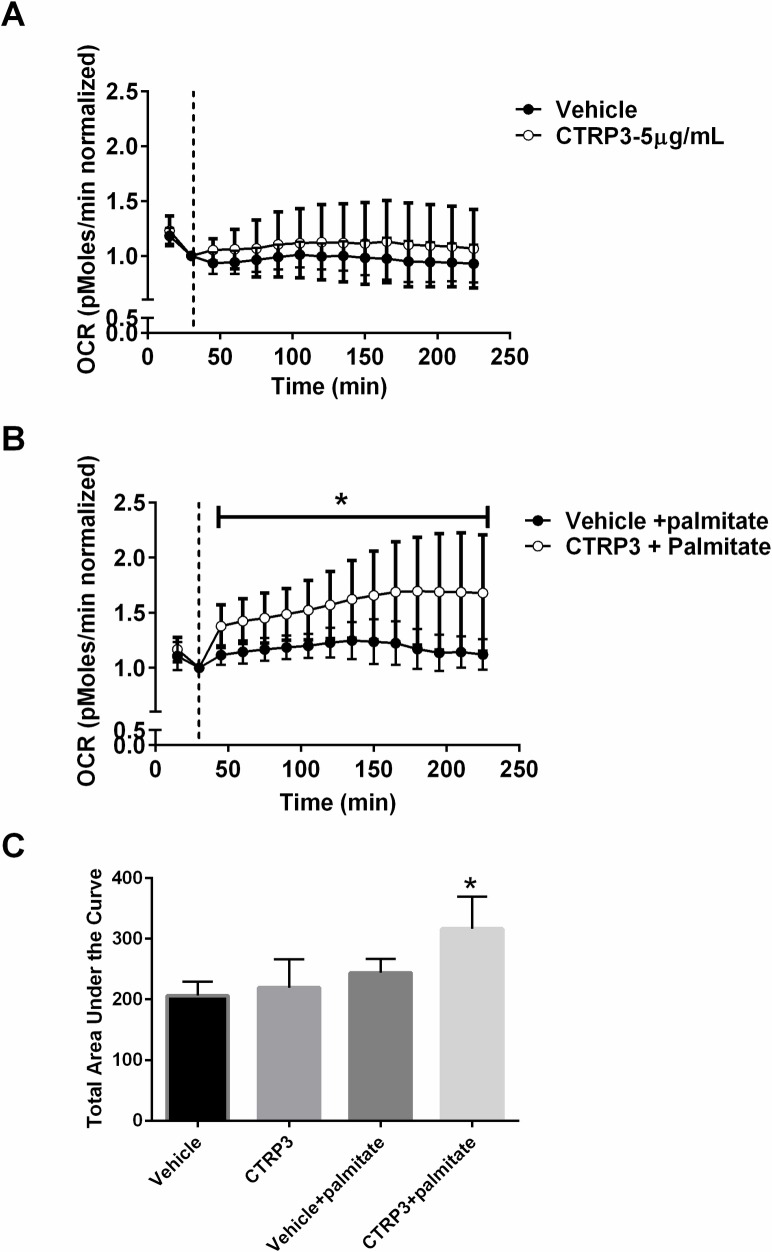
CTRP3 increases oxygen consumption.Cells were pre-incubated with 5 μg/ml recombinant CTRP3 or vehicle for 1 H before being placed into the XFe24 Extracellular Flux Analyzer (Seahorse Bioscience) and oxygen consumption rate (OCR) was determined. OCR was measured in the absence (A) or after the addition of 200 μM palmitate (B) added at 15 minutes (vertical line). C, Area under the curve was calculated (mean OCR value at each interval*time) for each treatment. Data represents the mean ± SD. Data represents pooled data from 3 independent experiments each performed in triplicate, *p < 0.05 vs. vehicle + palmitate.